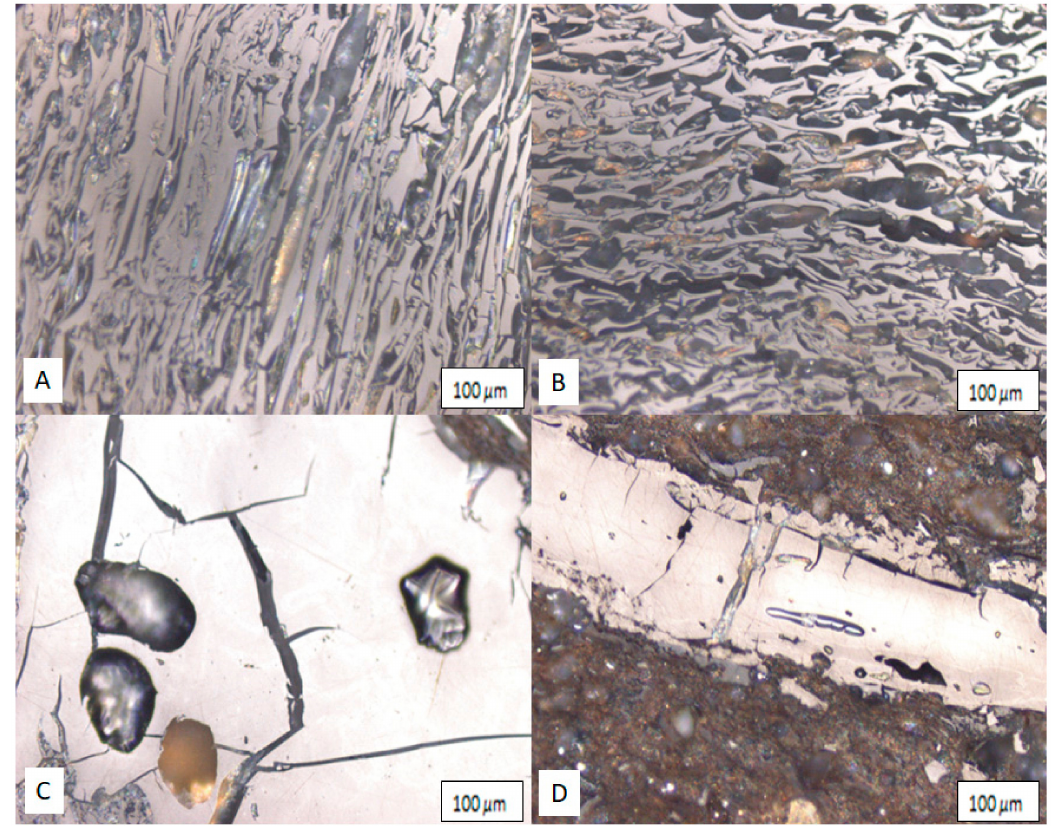
Figure 7. Photomicrograph of coal showing: ( A ) fusinite with pyrite inclusions; ( B ) semi-fusinite with pyrite inclusions; ( C ) pseudovitriite with detrital vitrinite particles; and ( D ) fusinite maceral surrounded by clay